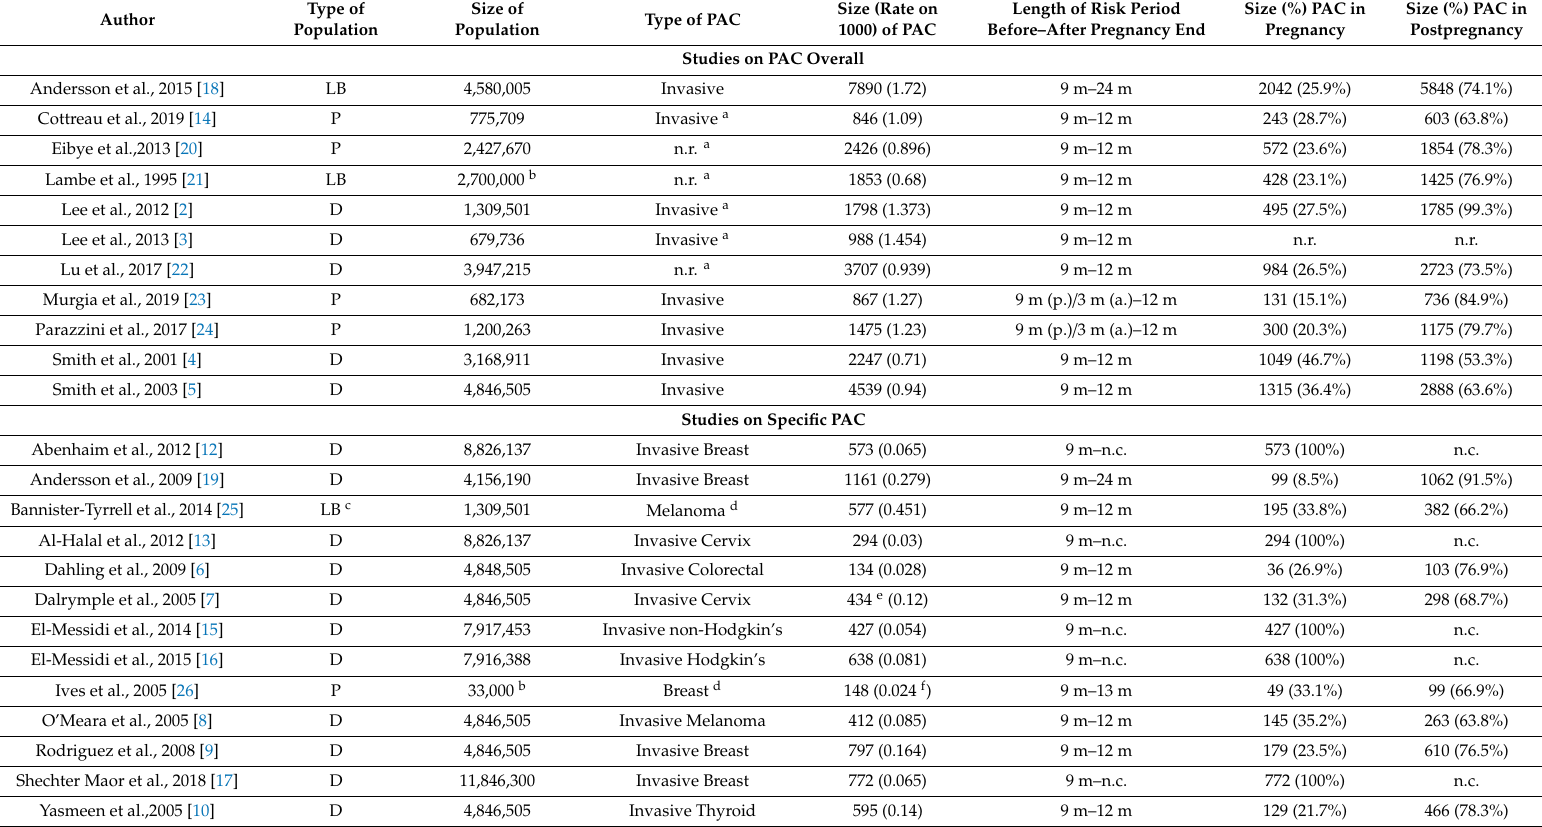
Table 2. Definition and estimated frequency of pregnancy-associated cancer (PAC). Studies on PAC overall and on specific